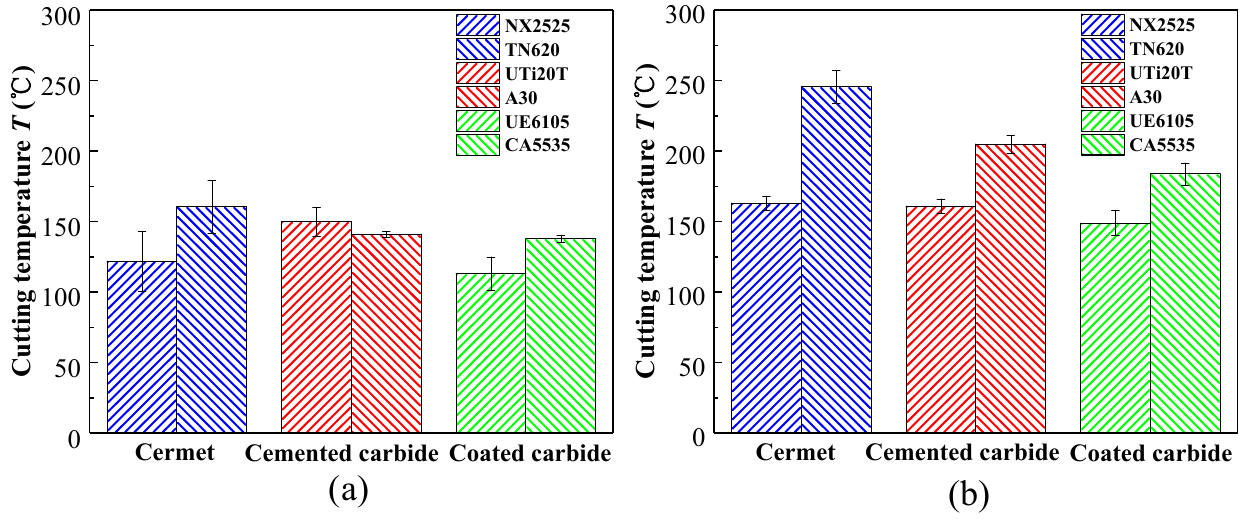
Figure 3. Cutting temperature for each tool at both cutting speeds: ( a ) 40 m/min and ( b ) 80 m/min. Furthermore, at the low cutting speed, the cutting forces of cemented carbide tools were smaller than those of the other tools, and the TN620 cermet tool had the highest cutting force. Figures 4–6 illustrate the wear morphologies of cutting tools at both cutting speeds, respectively. As shown in Figure 5, the cemented carbide tools had a built-up edge, which can decrease the cutting force by increasing the actual rake angle. Thus, in virtue of the built-up edge and anti-friction coating, the cemented carbide tools and coated carbide tools presented smaller cutting forces than those of cermet tools at the low cutting